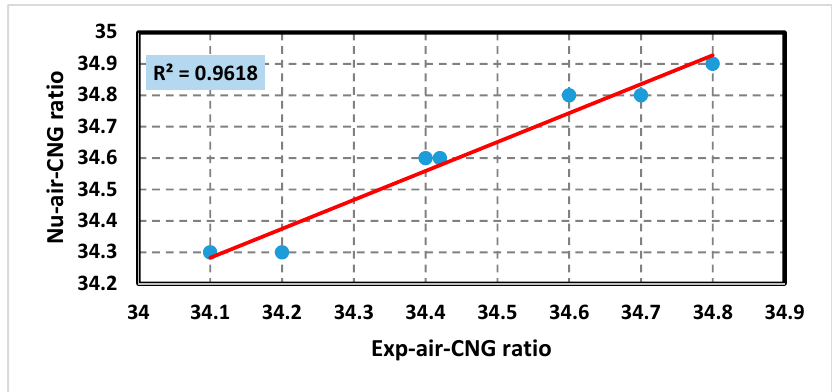
Figure 20. Variation of air-fuel ratio with engine speed according to numerical and experimental results for the new mixer model.